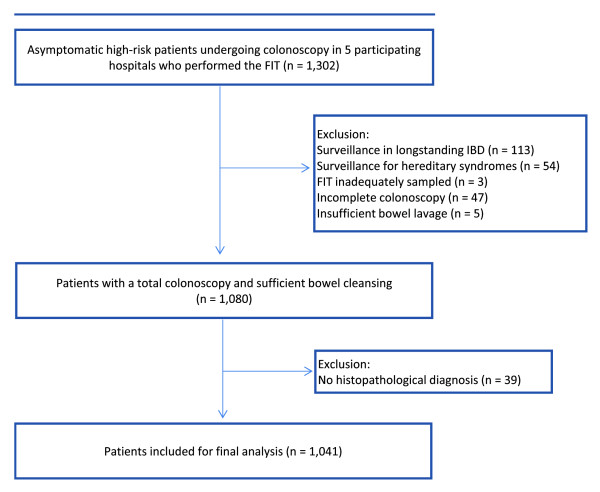
Study flow diagram.